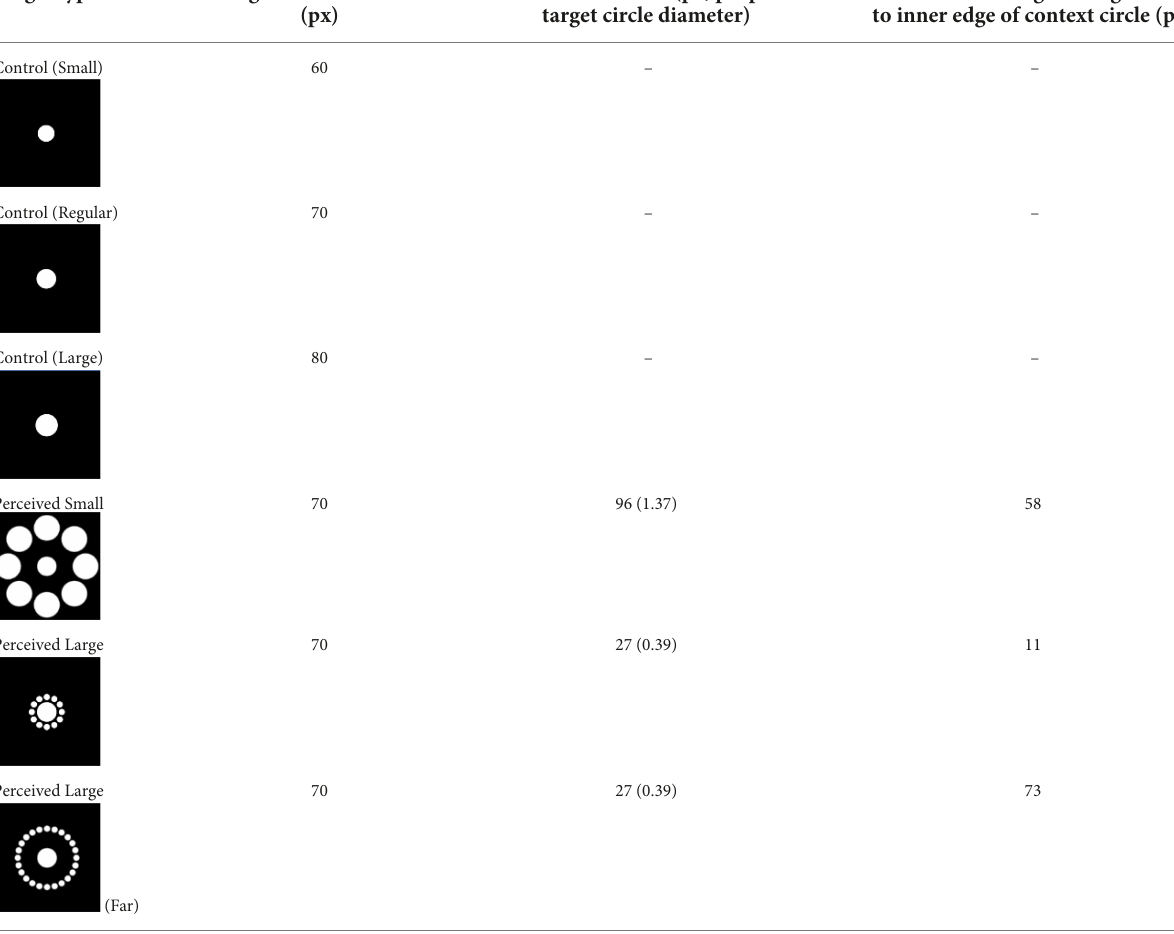
TABLE 3 Target type and